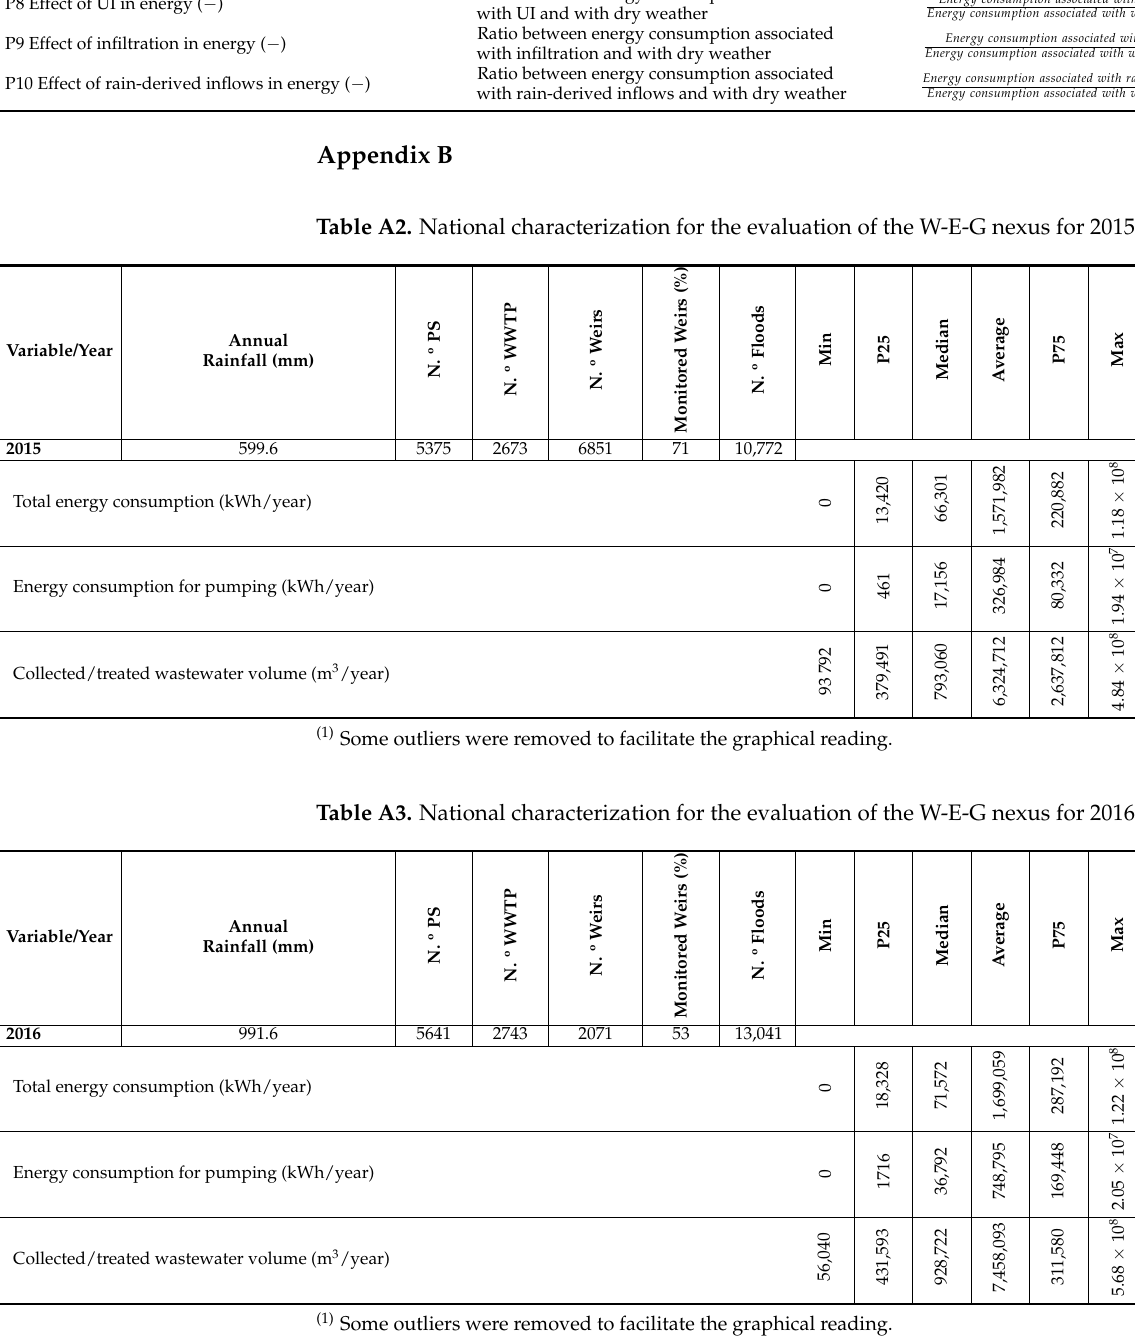
Table A1. Complete P7–P10 metrics formulation.